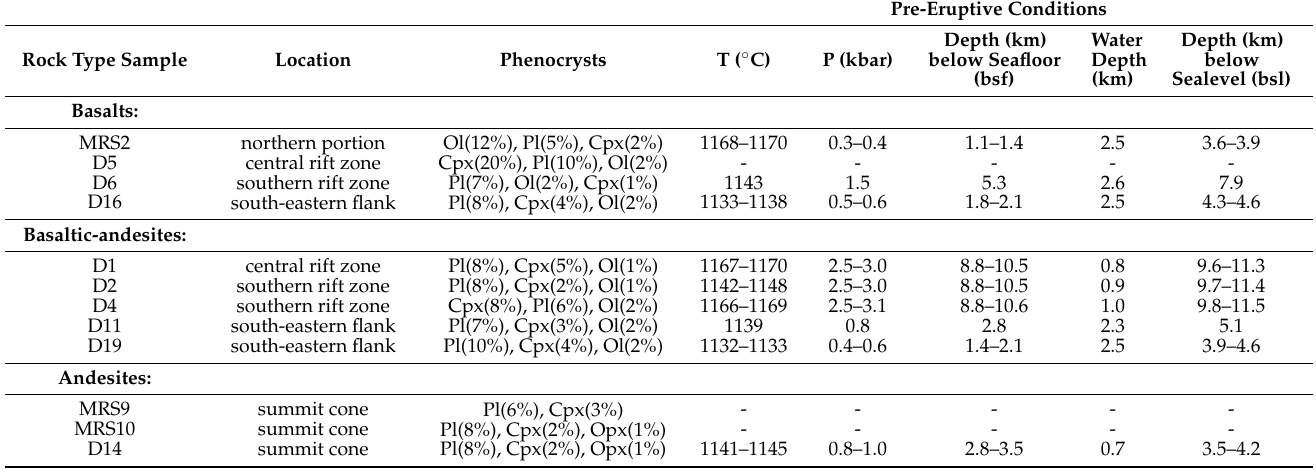
Table 1. Location, phenocryst assemblage and pre-eruptive conditions of Marsili lava samples discussed in text. All data have been reported in [18]. Phenocryst minerals (i.e., crystals with size > 0.1 mm, with no genetic connection) are listed by order of decreasing abundance (vol%); abbreviations: Ol, olivine; Opx, orthopyroxene; Cpx, clinopyroxene; Pl, plagioclase. Pre-eruptive conditions: set of pressure (P) and temperature (T) conditions [18] at which both plagioclase and pyroxene are liquidus phases. The P (kbar) was used to calculate the pre-eruptive source depth below seafloor (bsf), assuming a density value of 2.9 × 10 3 kg/m 3 , which is equivalent to a lithostatic gradient of 3.5 km/kbar. The source depth below sea level (bsl) was obtained by adding the water depth to the bsf